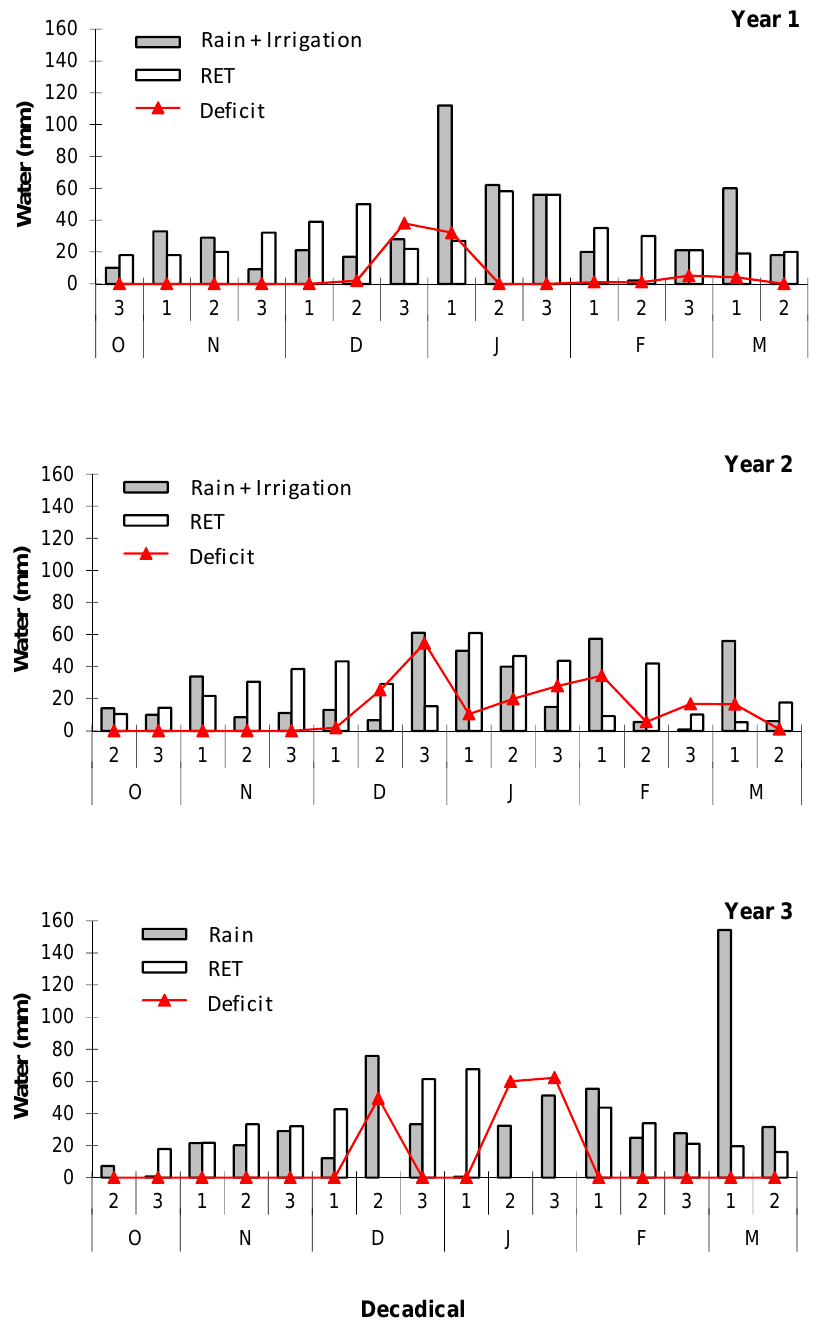
Figure 1. Precipitation, real evapotranspiration (RET), and water deficit during three years on no-till corn.